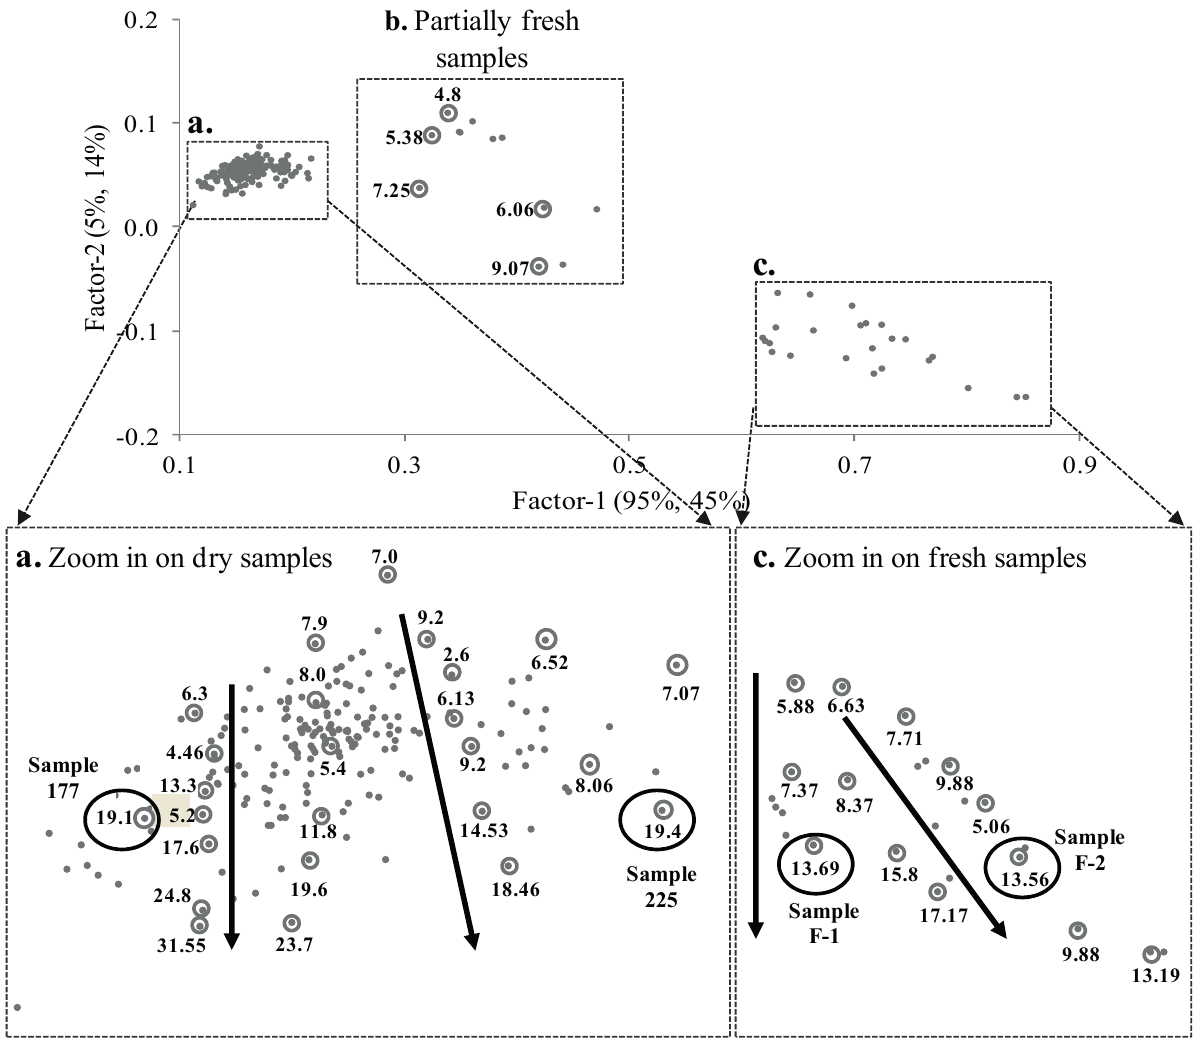
Figure 7. Score plot for the partial least squares (PLS) model for crude protein (CP) using eight slopes. Numbers next to gray circles represent the protein values (reference). Black circles indicate two specific dry samples (177 and 225) and two specific fresh samples (F-1, F-2). Arrows indicate the change from top to bottom in protein content measured in the samples. ( a ) Zoom in on dry samples, ( b ) Partially fresh samples, ( c ) Zoom in on fresh